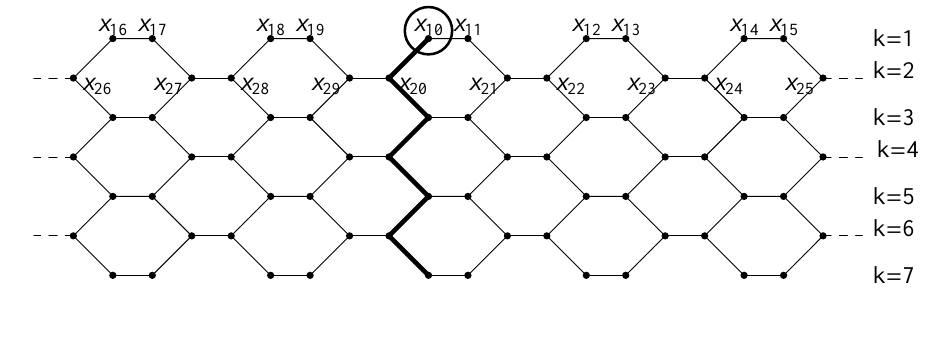
[2 p, q ] Lattice with p = 5 and q = 7 6